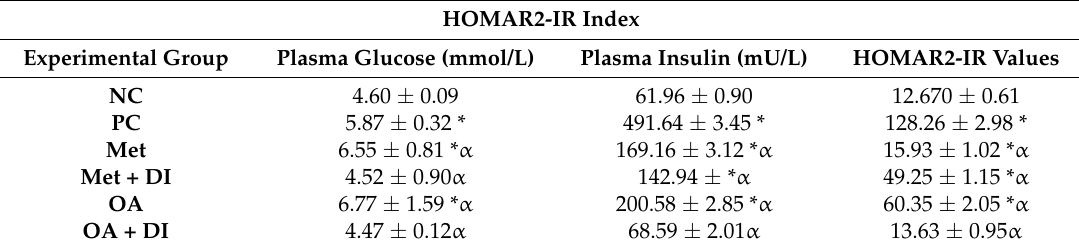
Table 2. Effects of OA with and without diet intervention on HOMAR index after the treatment period. Values are presented as standard error of mean ± SEM.